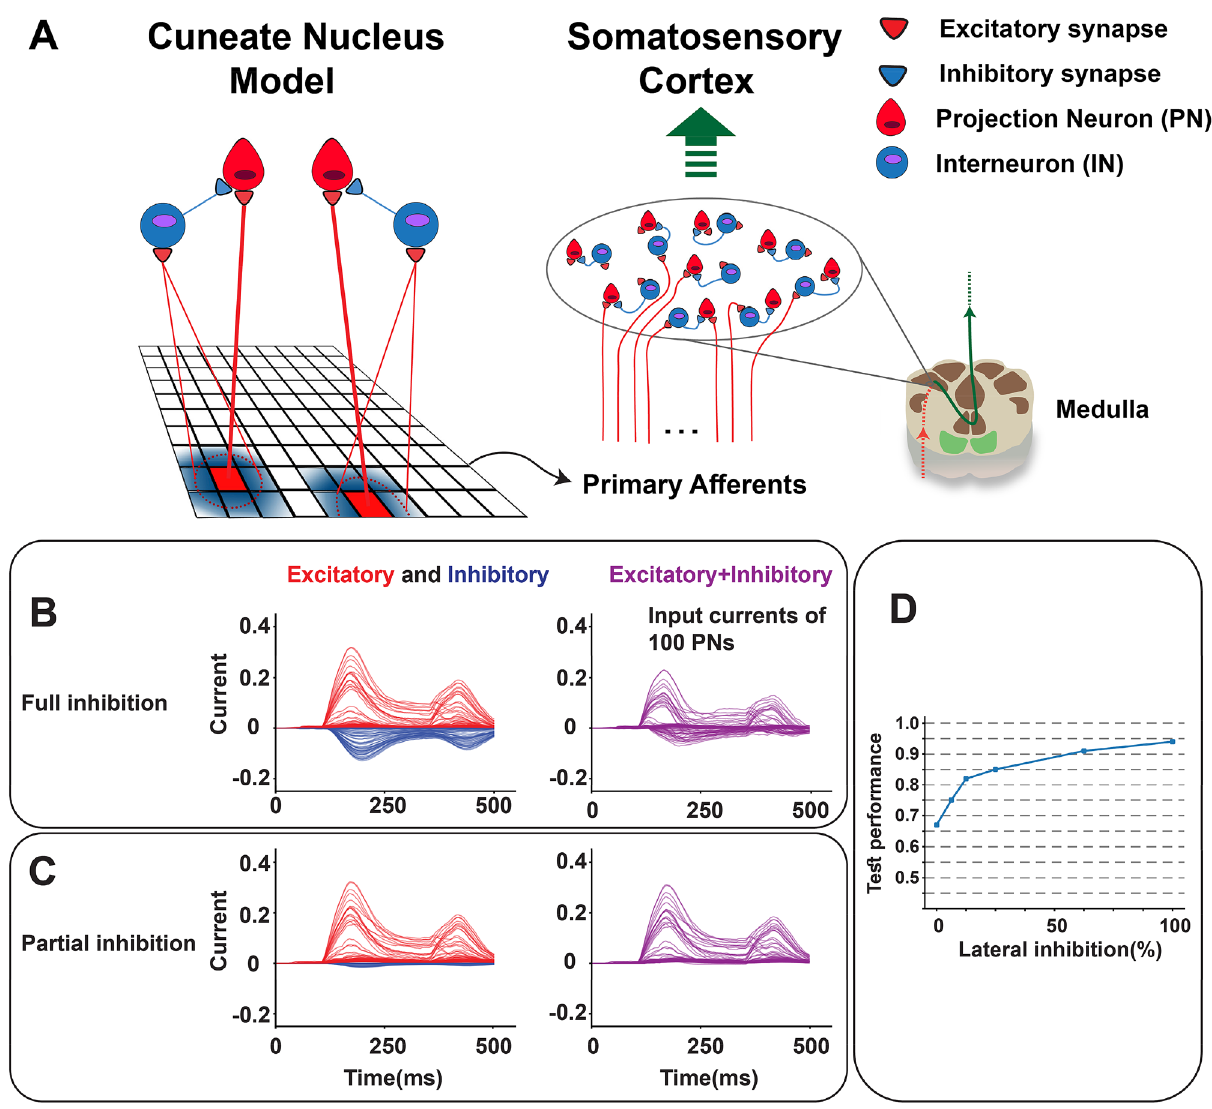
Figure 6. Modeling the CN neuronal circuitry and synaptic currents (excitatory and inhibitory) for edge indentation stimulus. ( A ) The primary afferents make excitatory synaptic connections with both PN and IN sub-populations. Their synaptic types are indicated by red (excitatory) and blue (inhibitory) triangles. Input currents of 100 PNs when full ( B ) and partial ( C ) inhibition comes from INs to PNs while edge stimulus indents the mechanoreceptor grid. Two peaks in the current traces are generated by the onset and end of the indentation profile. ( D ) Performance of the spiking network when the amount of lateral inhibition is increased within the CN